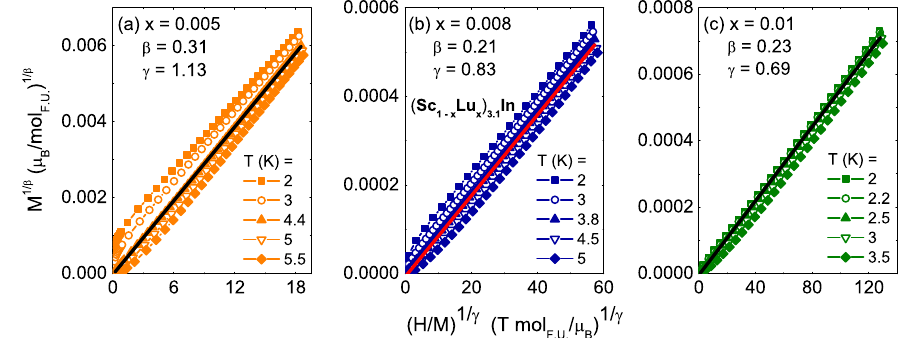
1 = β vs ð H=M Þ 1 = γ isotherms for (a) x ¼ 0 . 005 , (b) x ¼ 0 . 008 , and (c) x ¼ 0 . 01 with linear fits